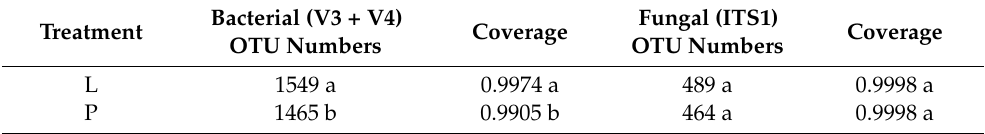
Table 5. Operational taxonomic units for soil bacteria and fungi.